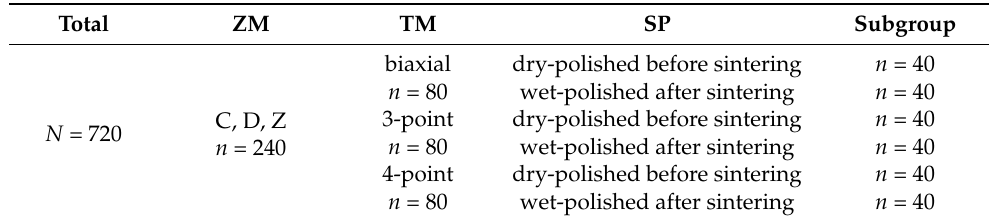
Table 2. Division of specimens with abbreviation used. TM: test method, SP: specimen preparation, ZM: zirconia